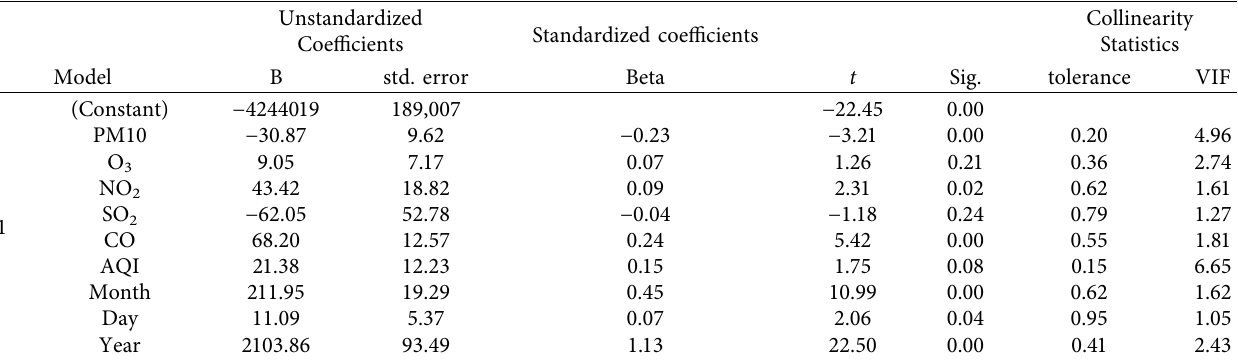
Table 5: Coefficients of the linear regression.